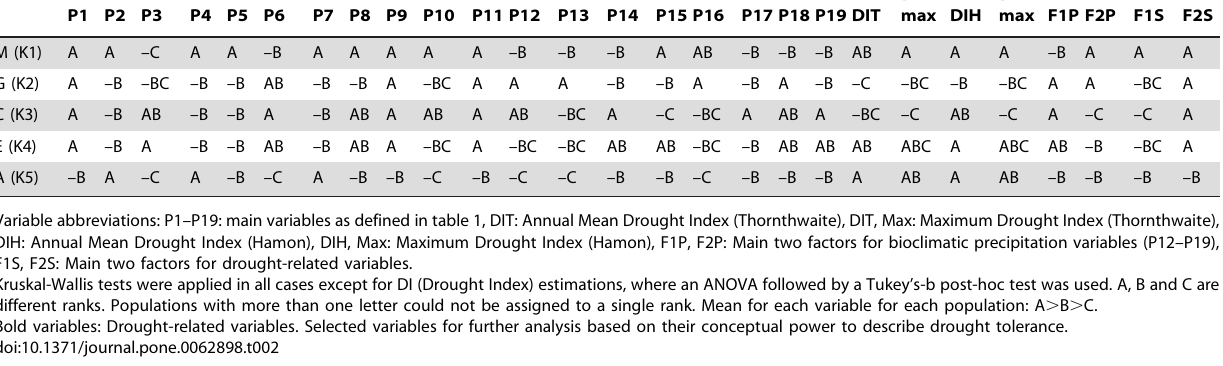
Table 2. Pairwise comparisons of significant variation for each bioclimatic variable, component and drought severity estimator in relation with population structure (p-value , 0,001).